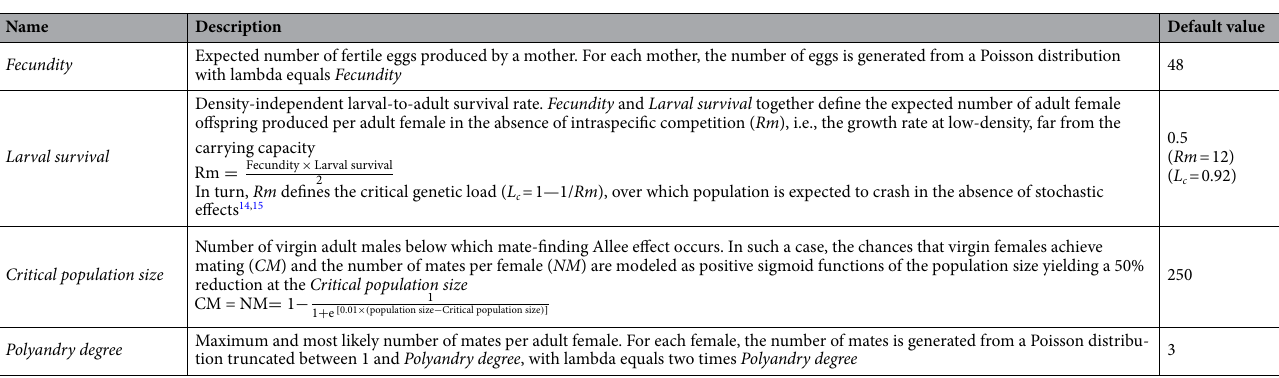
Table 1. Main population parameters. A description and default value are shown for each